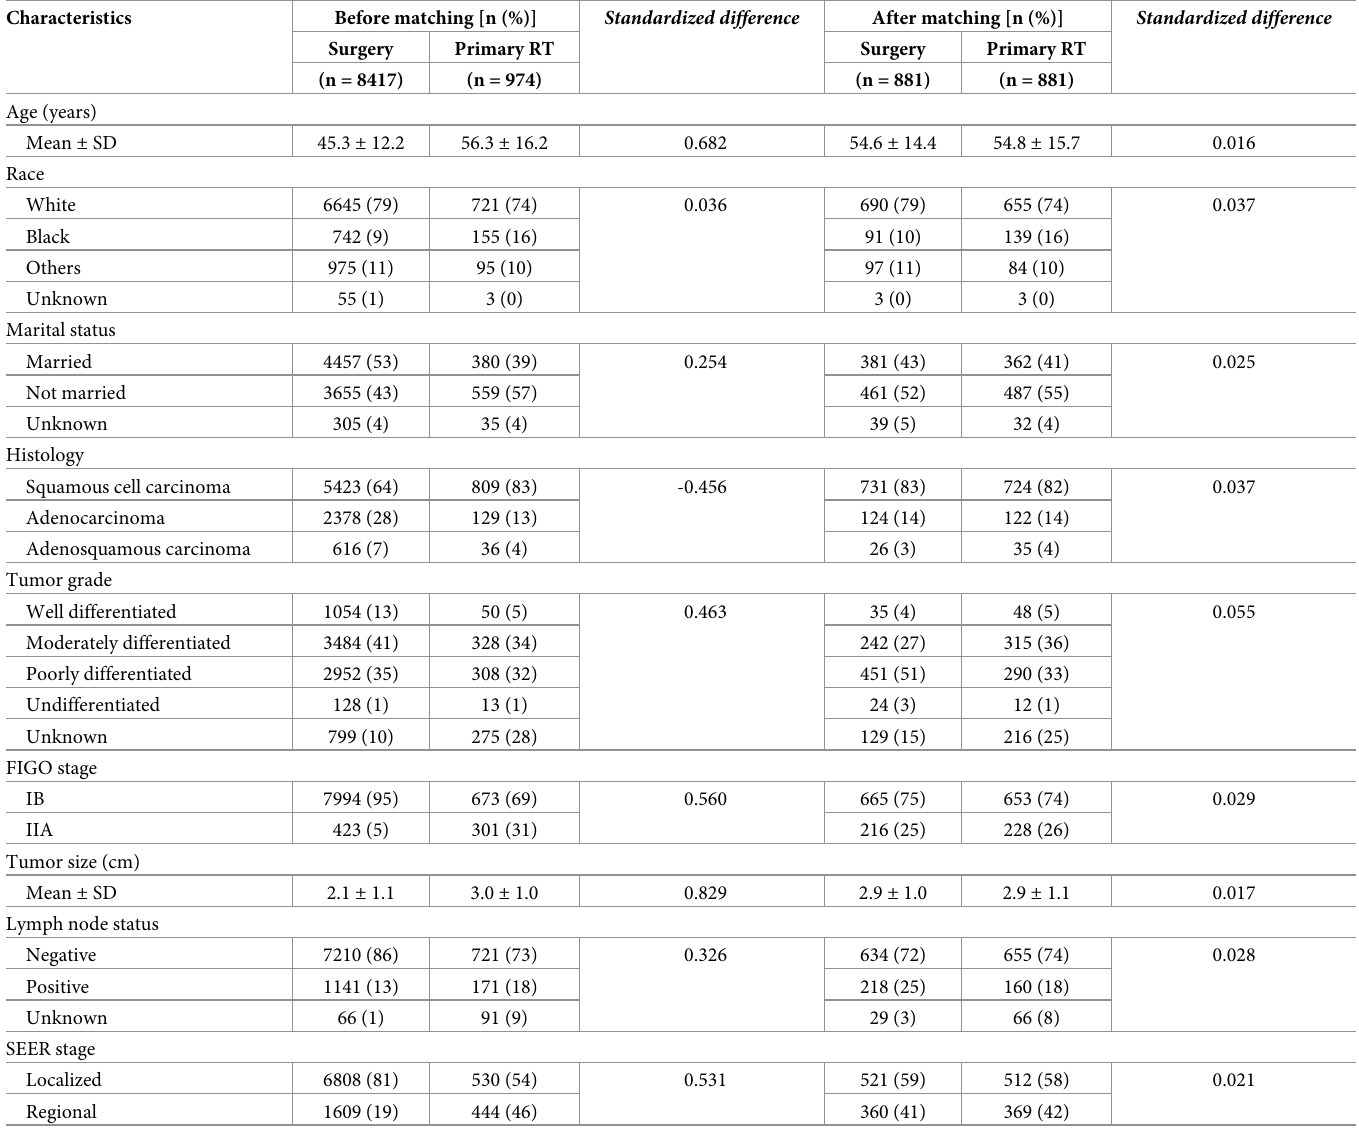
Table 2. Distribution of baseline variables before and after propensity score matching in cohort A.